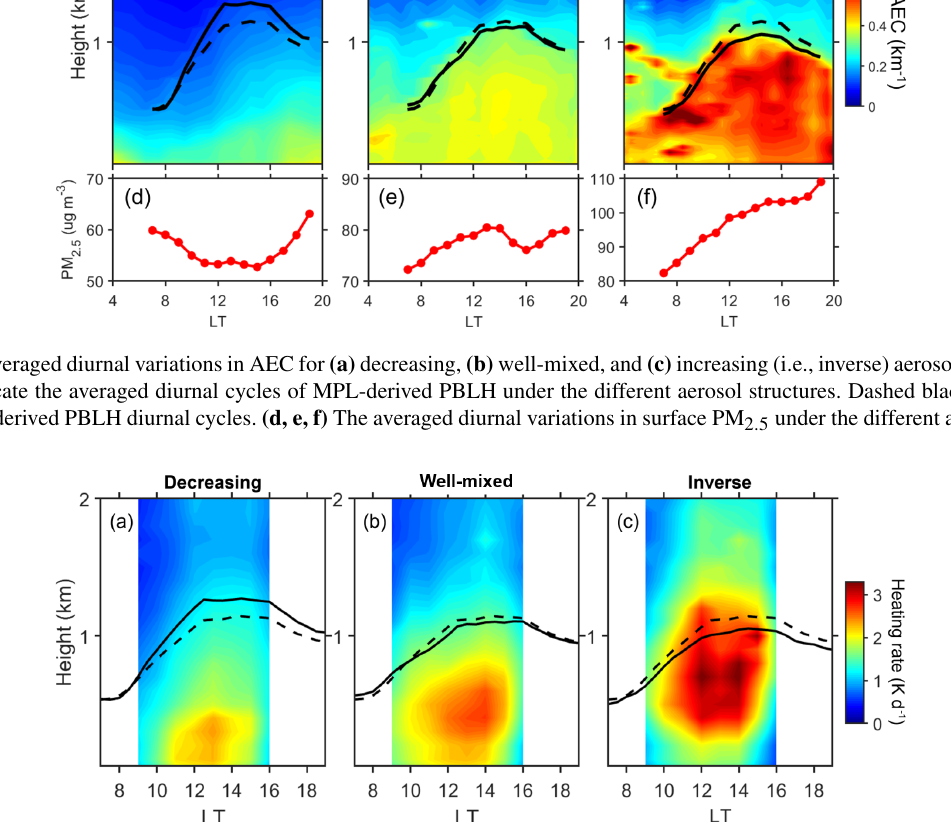
Figure 7. The averaged diurnal variations in aerosol radiative forcing in the vertical for (a) decreasing, (b) well-mixed, and (c) increasing (i.e., inverse) structures of aerosol loading. Solid black lines indicate the mean diurnal cycles of MPL-derived PBLH under different aerosol structures. Dashed black lines represent the mean MPL-derived PBLH diurnal